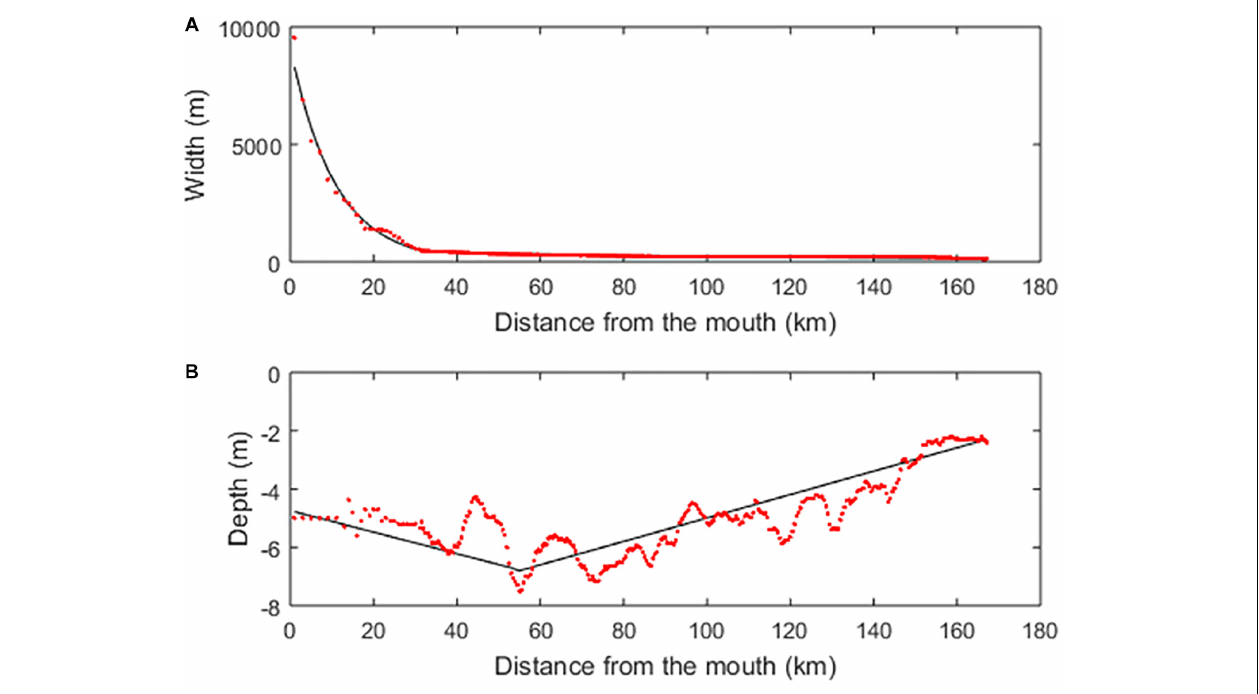
FIGURE 2 | (A) Width and (B) depth profiles of the Seine estuary from its mouth to Poses. Red dots correspond to observations while black lines correspond to the values used to constrain C-GEM’s